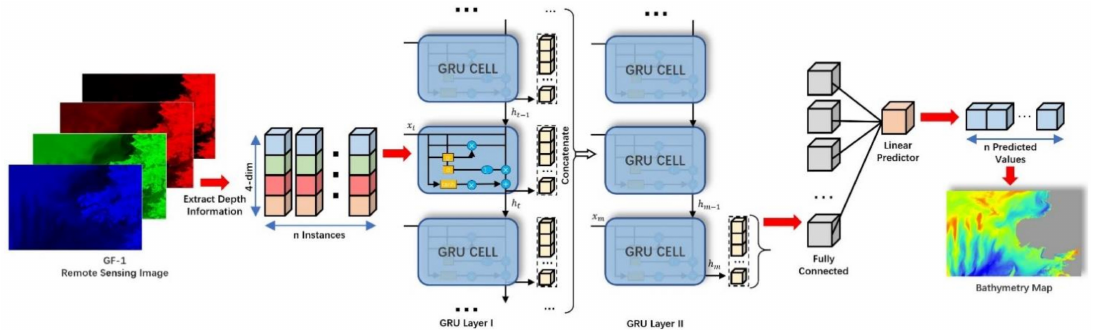
Figure 8. Diagram of the